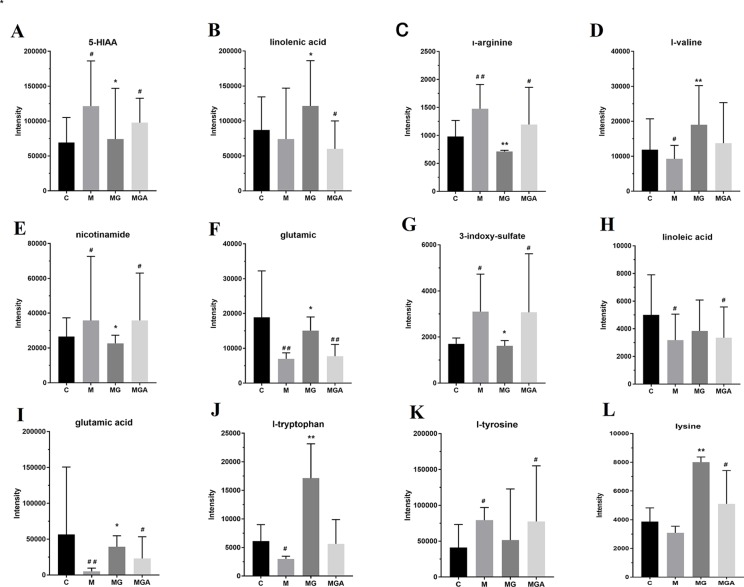
Effect of in vitro co-incubation of fecal samples on fecal bacterial metabolite levels, *P < 0.05, **P < 0.01 compared with the Model group; #
P < 0.05, ##
P < 0.01 compared with the Control group. (C, feces of Control group; M, feces of Model group; MG, water extraction of GU added into feces of Model group; MGA, water extraction of GU and antibiotic mixed solution added into feces of Model group.) (A) 5-HIAA; (B) linolenic acid; (C) l-arginine; (D) l-valine; (E) nicotinamide; (F) glutamic; (G) 3-Indoxyl sulfate; (H) linoleic acid; (I) glutamic acid; (J) l-tryptophan; (K) l-tyrosine; (L) lysine.